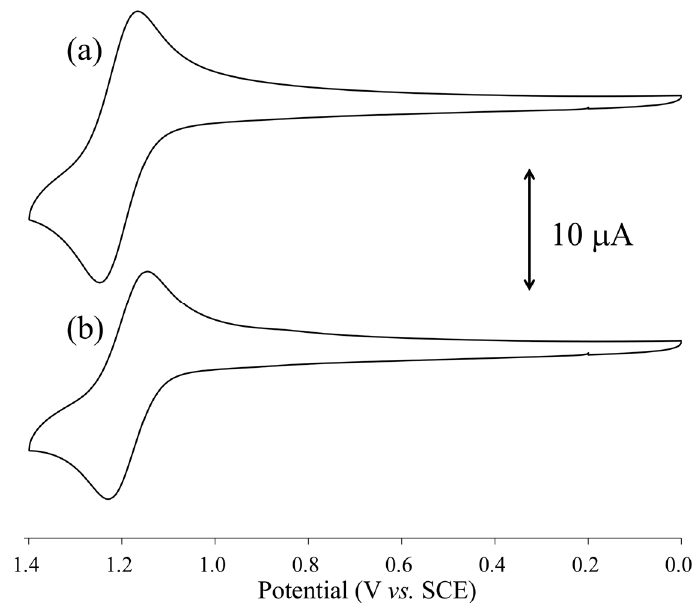
Figure 7. Cyclic voltammetry (CV) diagrams, in CHCl 3 :OCMe 2 (1:1, v / v ) solvent, of: ( a ) [1(OCMe 2 ) 2 ] ; and ( b ) [2(OCMe 2 ) 2 ] .